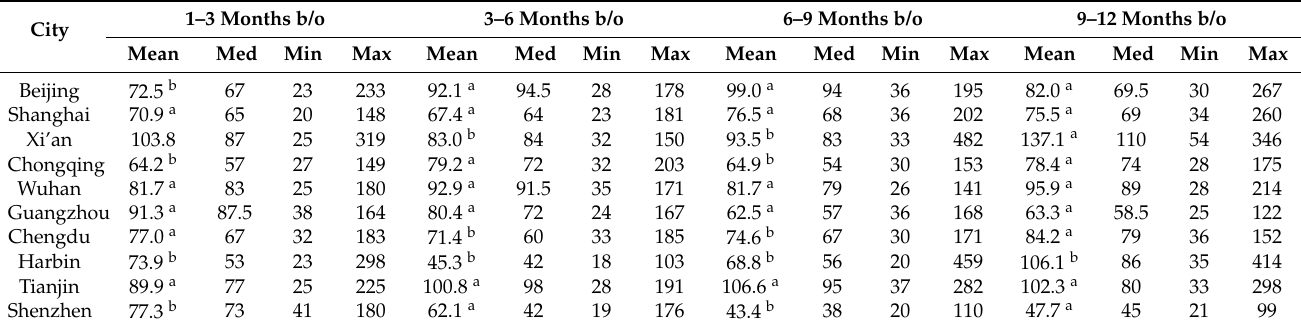
AQI scores and individual air pollutant concentration levels in all cities varied prior to the outbreak. Cities such as Xi’an, Harbin, and Tianjin, which recorded high AQI scores during the outbreak also had similar scores before the outbreak. Table 2. Descriptive statistics for AQI ( µ g m − 3 ) in 10 mega-cities before the COVID-19 outbreak.